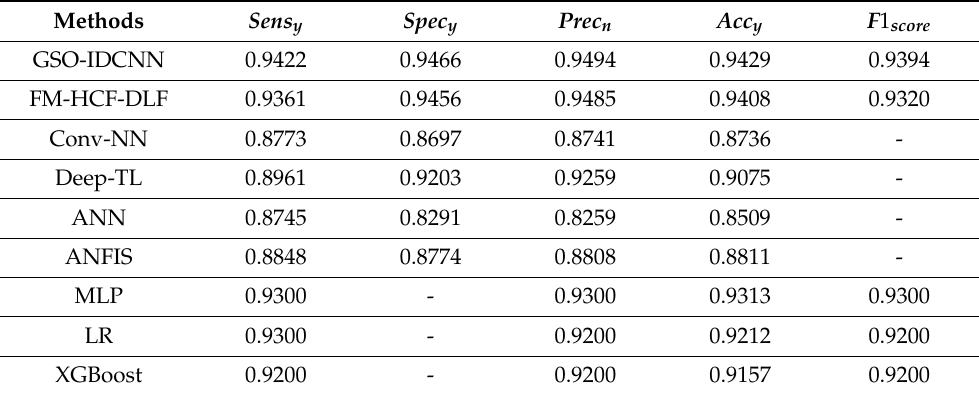
Table 2. Comparative studies of the existing models with the presented GSO-IDCNN